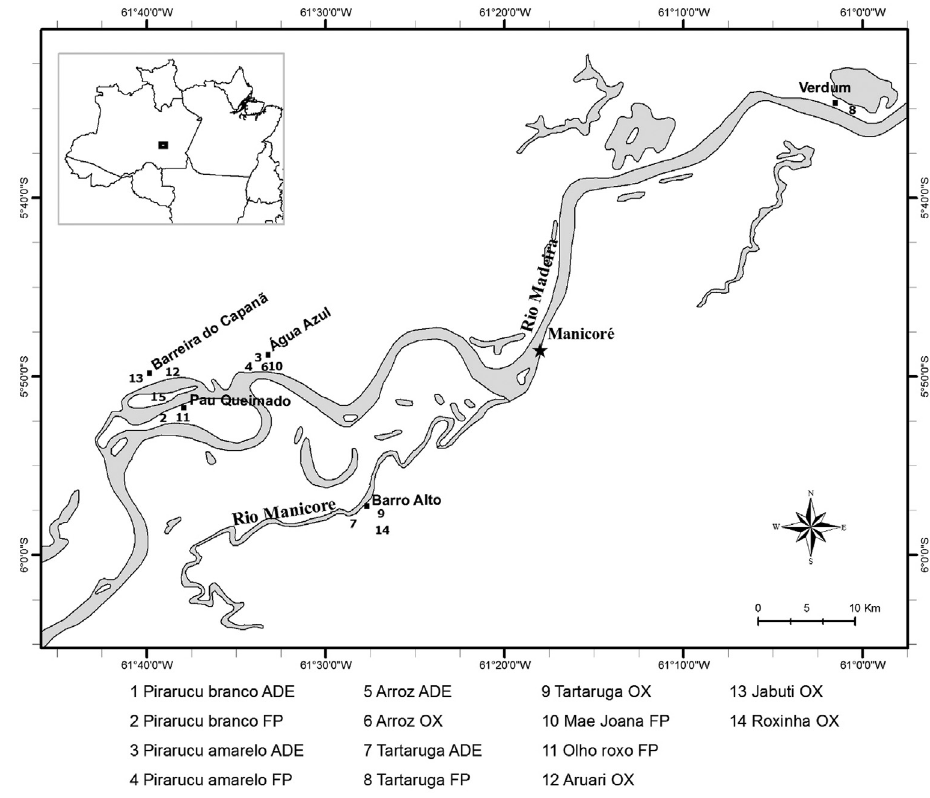
Figure 1 - Map showing the communities of smallholder farmers in the municipality of Manicoré, along the middle Madeira River, Amazonas, Brazil, where manioc varieties were sampled. The numbers correspond to the varieties’ names and the soil types in which they were grown. Soil types are coded as ADE (Amazonian dark earths), FP (floodplain) and OX (Oxisols).